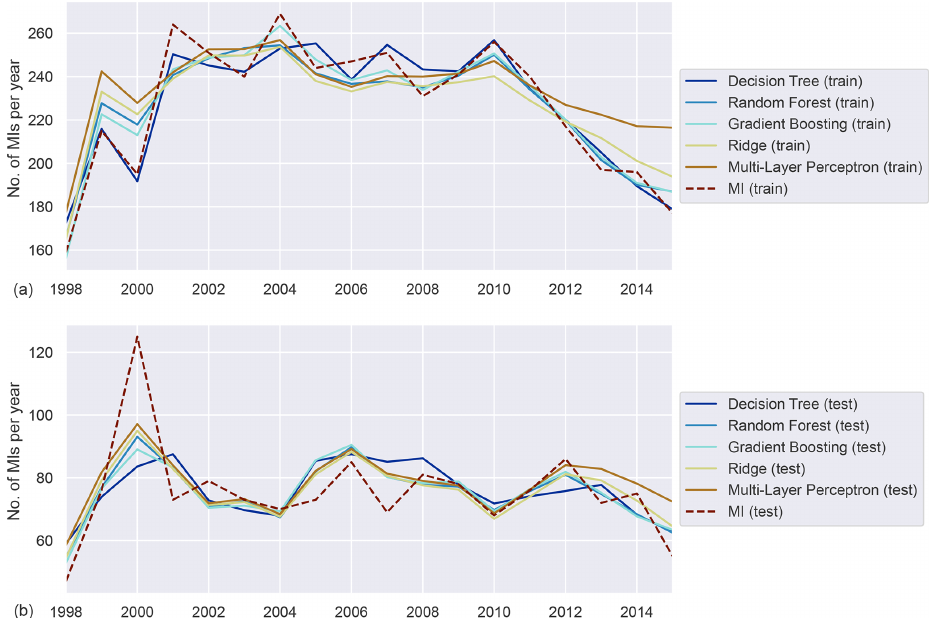
Figure A4. Annually aggregated predictions of MI in the diabetic population for all models. Predicted (solid) and observed MI (dashed) for training (a) and test (b)